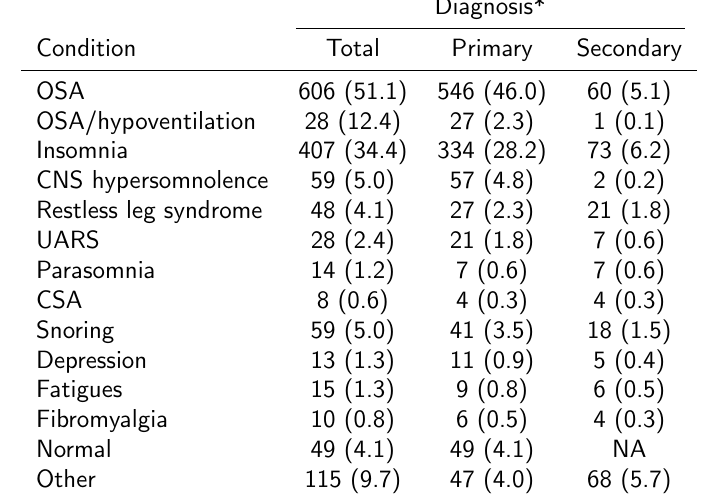
Table 2: Frequency for selected sleep disorder diagnoses as either a primary or secondary diagnosis based on physician medical chart